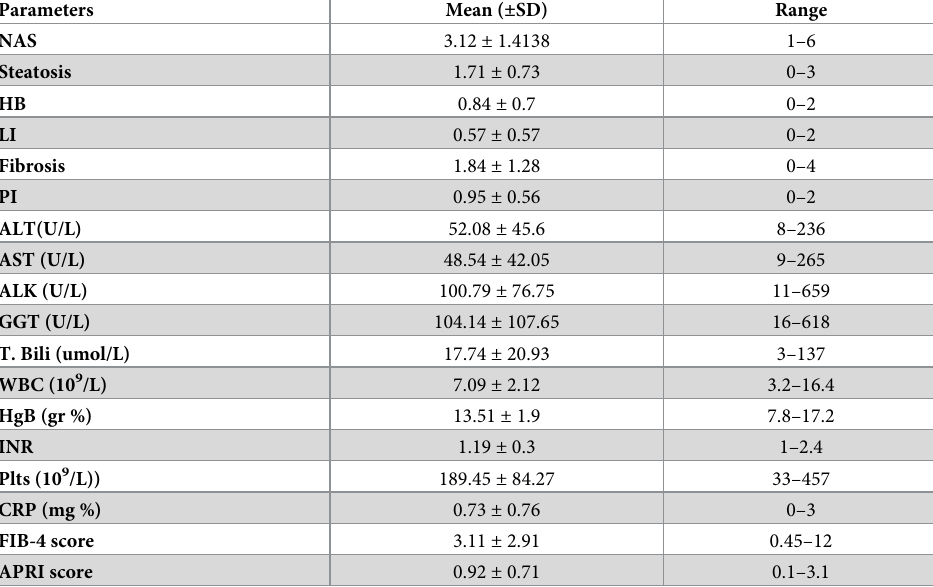
Table 3. Descriptive statistics of NAS, laboratory findings and fibrosis scores.